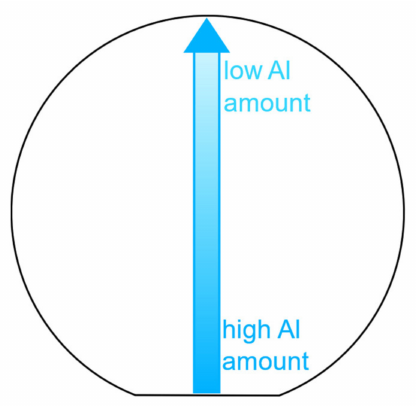
Figure A1. Schematic illustration of the gradient growth technique. The Al-cell points to the